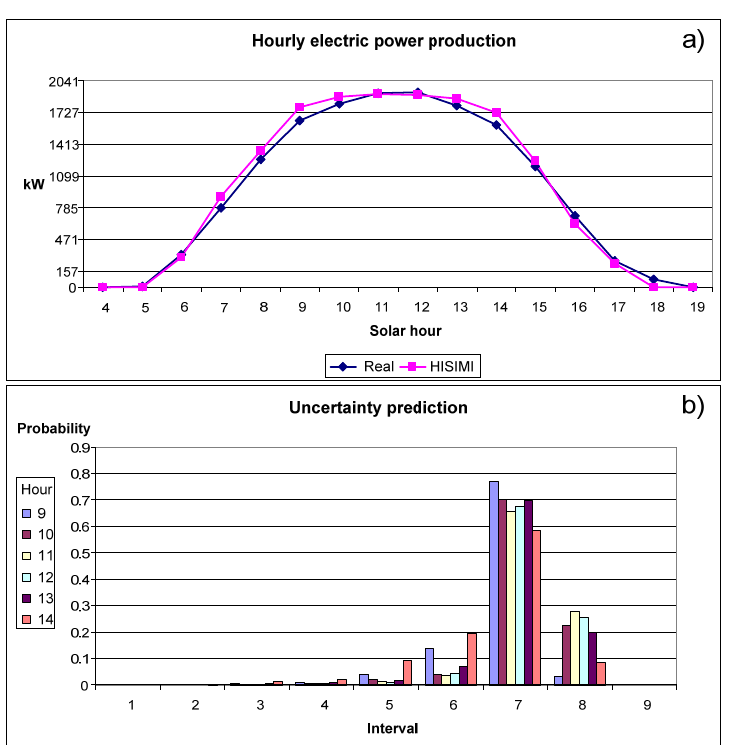
Figure 9. Forecasted hourly power production ( a ) and uncertainty prediction for six central hours; ( b ) (from 9:00 to 14:00) on a sunny